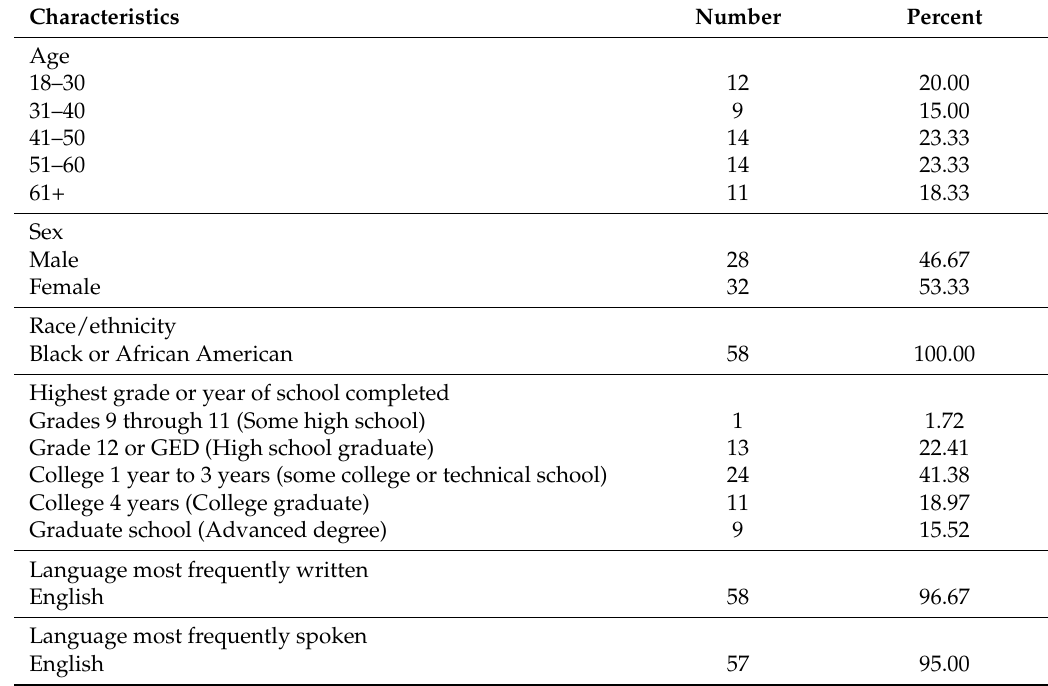
Table 2. Baseline characteristics between study groups ( n =